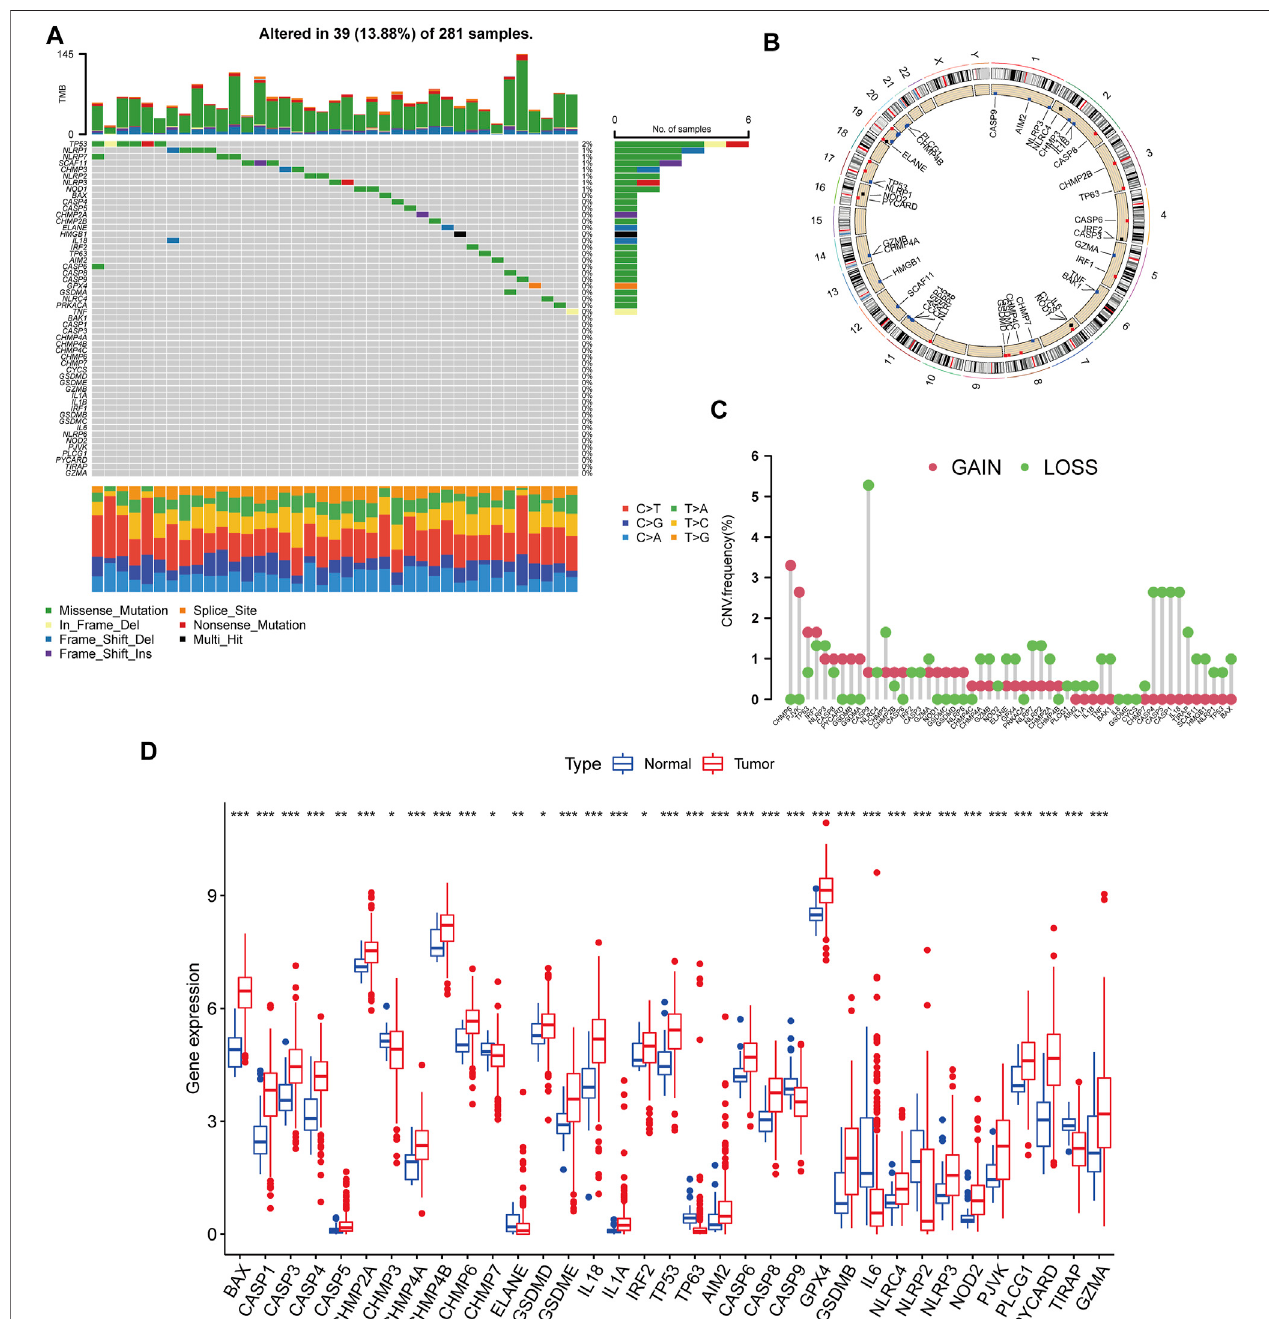
FIGURE1| GeneticandtranscriptionalvariationofPRGsinKIRP. (A) ThenumberofgeneticmutationsfoundinKIRPpatients.ThePRGs ’ mutationfrequencywas indicated by the number on the right. Each column represents one of the 39 TCGA samples in which the PRGs had at least one genetic change. (B) On the chromosomes, the position of the PRGs CNV changes. (C) The PRGs ’ CNV mutation frequency. The frequency of modi fi cation was displayed in the column. The frequencyofampli fi cationisshownbyareddot,whereasthefrequencyofdeletionisindicatedbyagreendot. (D) PRGsdifferentialexpressionstudyinnormaland KIRP tissues. * p < 0.05; ** p < 0.01; *** p <